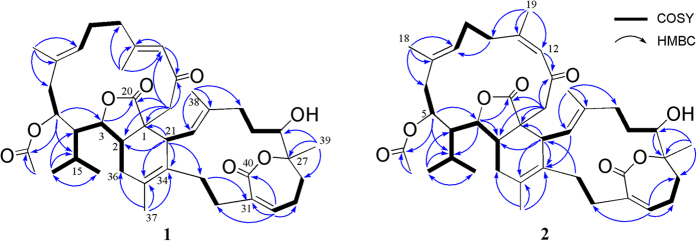
Selected COSY () and HMBC (→) correlations of 1 and 2.